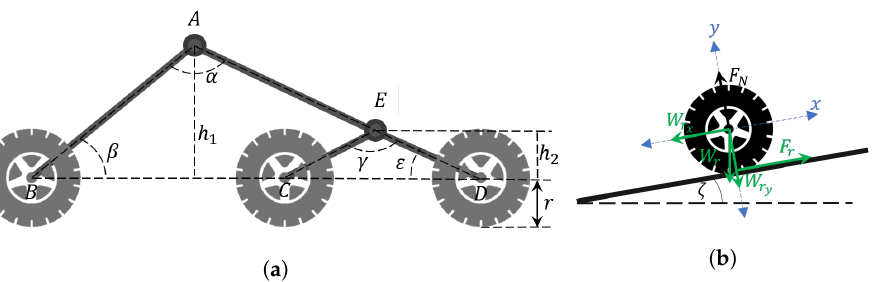
Figure 2. Design of the rocker-bogie suspension system: ( a ) complete rocker-bogie suspension; ( b ) wheel force diagram.